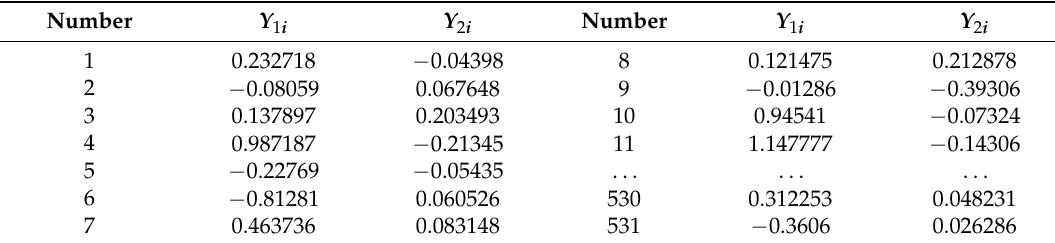
Table 3. Principal component score (coordinates).